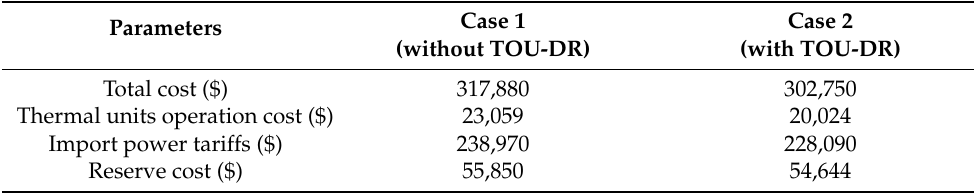
Figure 18. Starts-up cost of thermal units in case 2. Table 6. Optimization costs